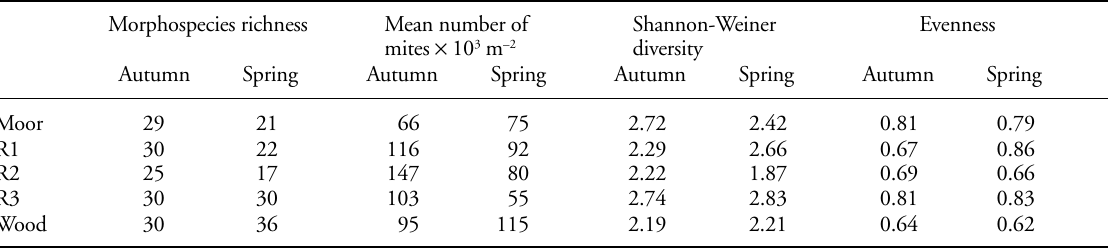
Table 2. Morphospecies richness, density, diversity and heterogeneity of morphospecies distribution (evenness) of oribatid mites from Loch Garten transect sites during autumn 1998 and spring 1999. Morphospecies